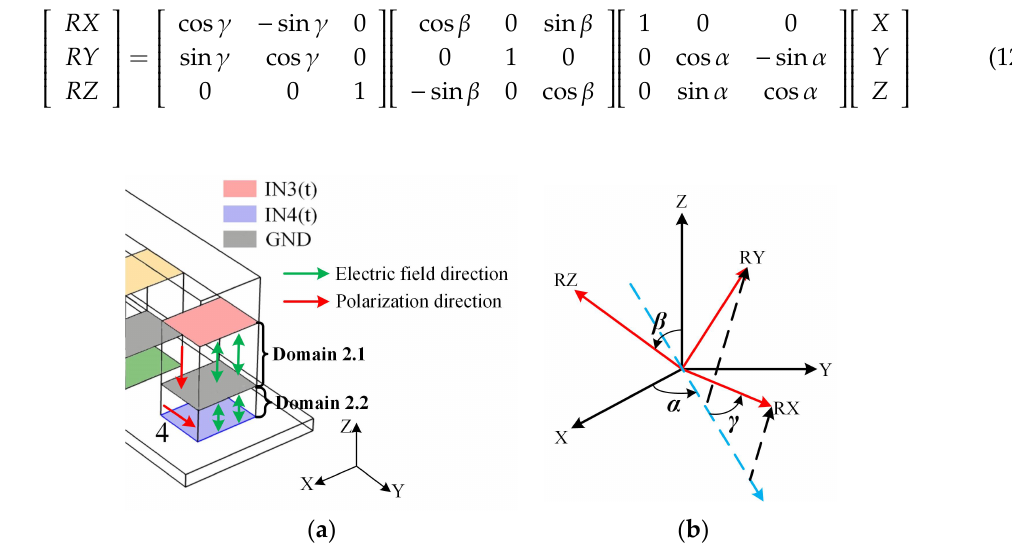
Figure 7. ( a ) Relationship between polarization direction and electric field direction; ( b ) relationship between rotating coordinate system and global coordinate system.